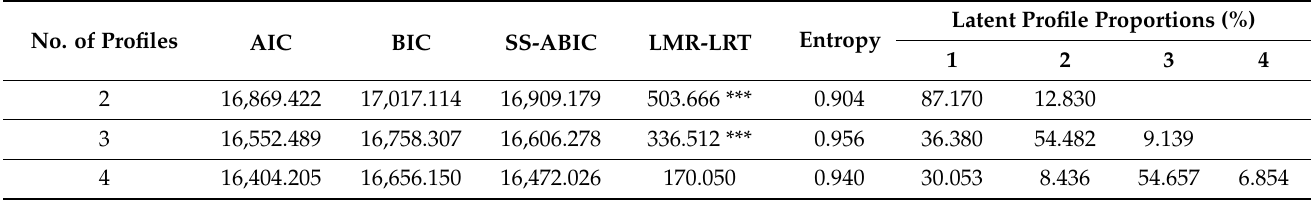
Table 2. Model fit statistics of latent profile models (N = 569).